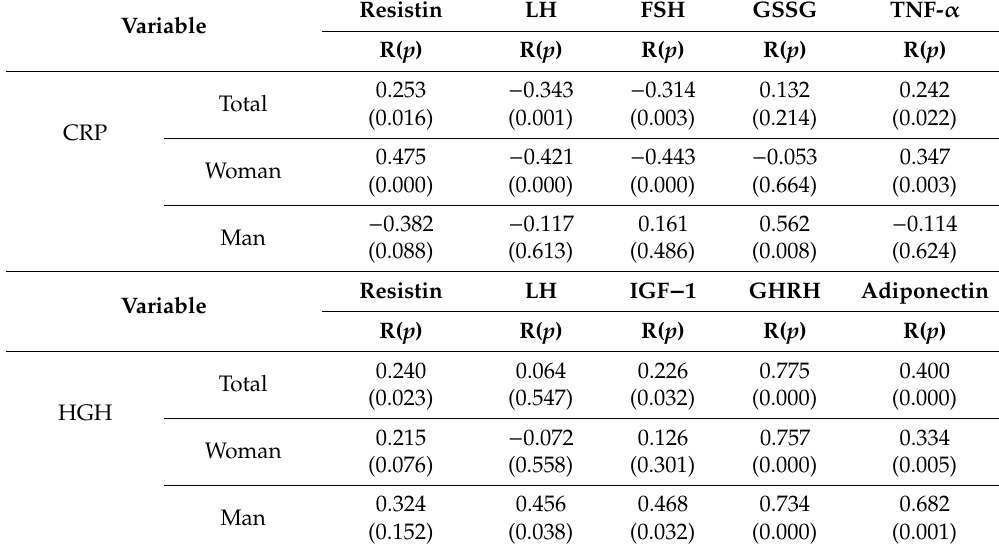
Table 2. The Spearman rank correlation analysis for insulin, including selected variables in the general group, men and women. Cortisol HGH Adiponectin IL-1 α Variable R( p ) R( p ) R( p ) R( p ) − 0.333 − 0.236 Total (0.001) (0.025) Insulin